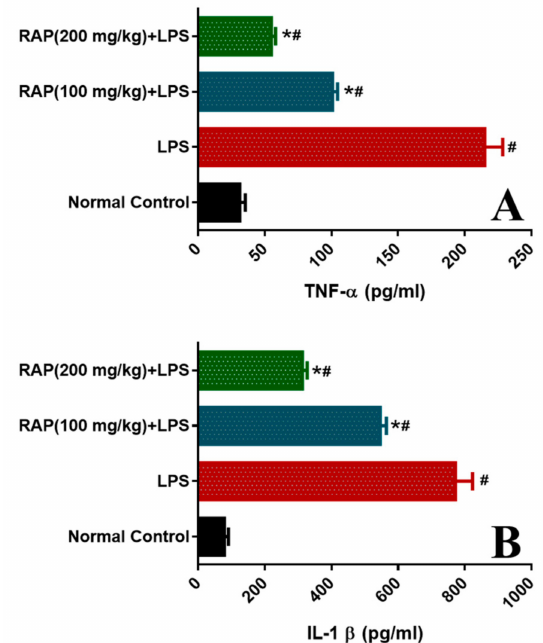
Figure 4. E ff ect of RAP (100 and 200 mg / kg) on pro-inflammatory cytokine levels in the plasma of LPS-induced systemic inflammation. ( A ) Tumor necrosis factor-a (TNF- α ), and ( B ) Interleukin-1 β (IL-1 β ). Results are mean SEM of seven animals per group. ‘*’ denotes significant di ff erences compared with the normal control group ( p < 0.05); ‘#’ denotes significant di ff erences compared with the LPS group ( p <